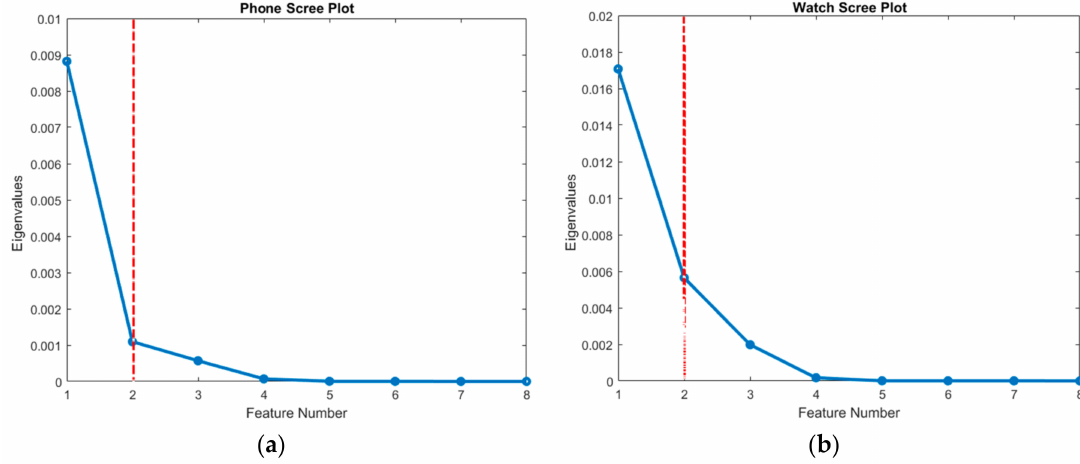
Figure 3. Scree plot of the ( a ) Phone and ( b ) Watch